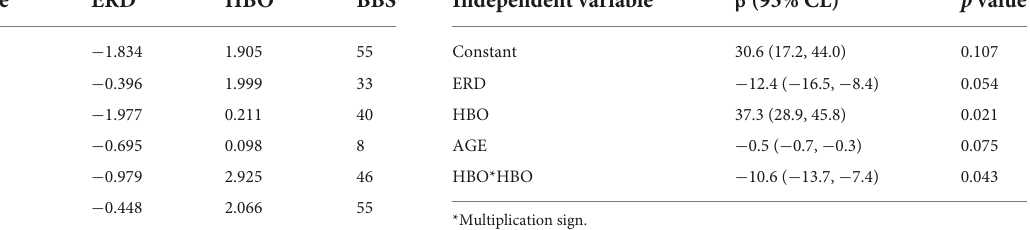
TABLE 1 Age, ERD, HBO, and BBS of the patients. Patient